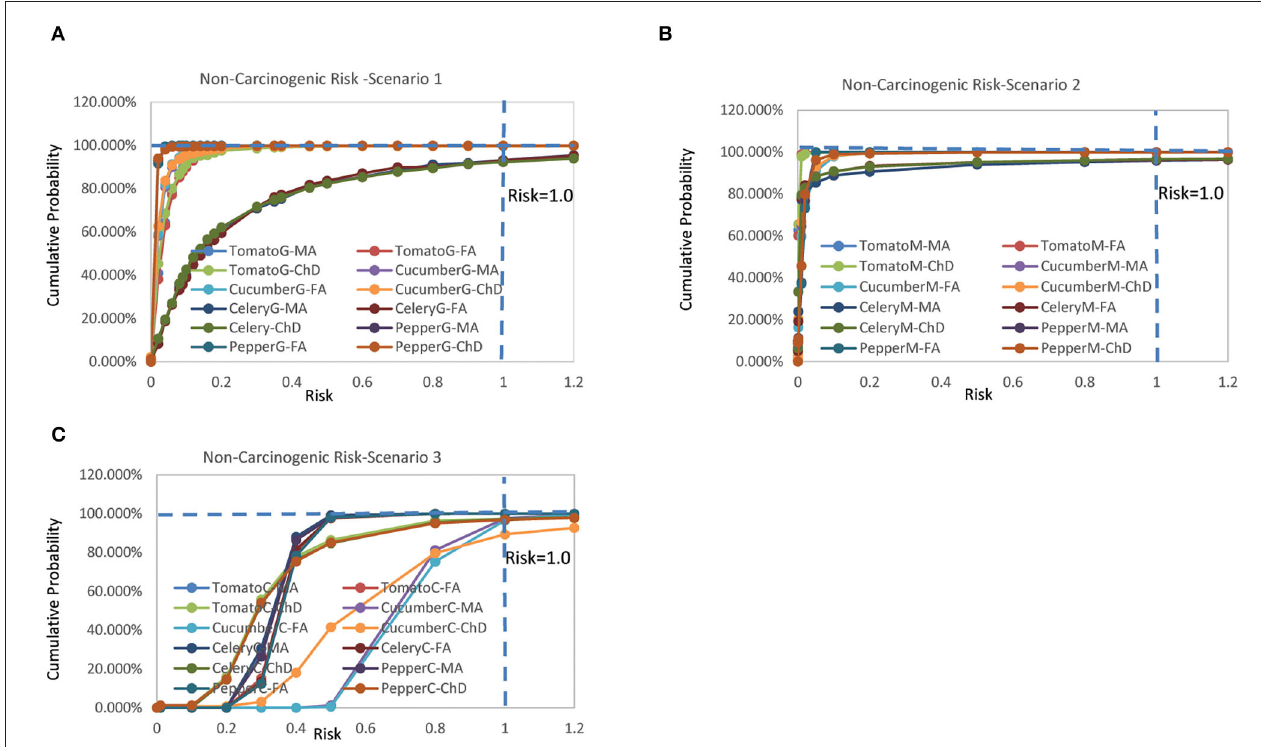
FIGURE 1 | Cumulative probability of non-carcinogenic risks for (A) scenario 1, (B) scenario 2, and (C) scenario 3 (Jinan, China,